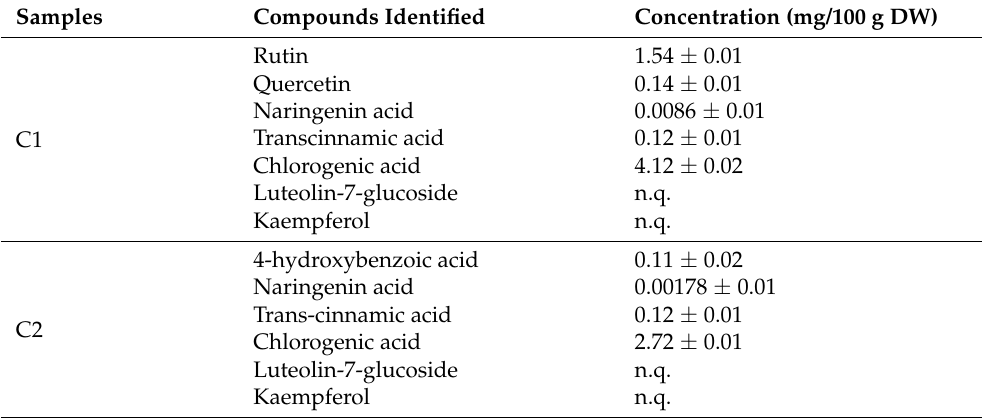
Table 4. Individual compounds identified by HPLC from the two companies.